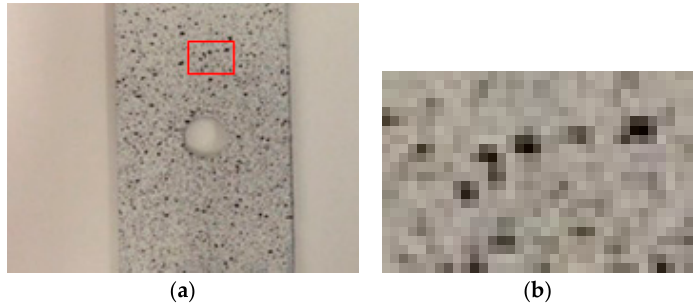
Figure 1. ( a ) Texture resulting after painting with an atomizer on a metallic surface, after [9]; ( b ) detail of the texture with isolated dots.